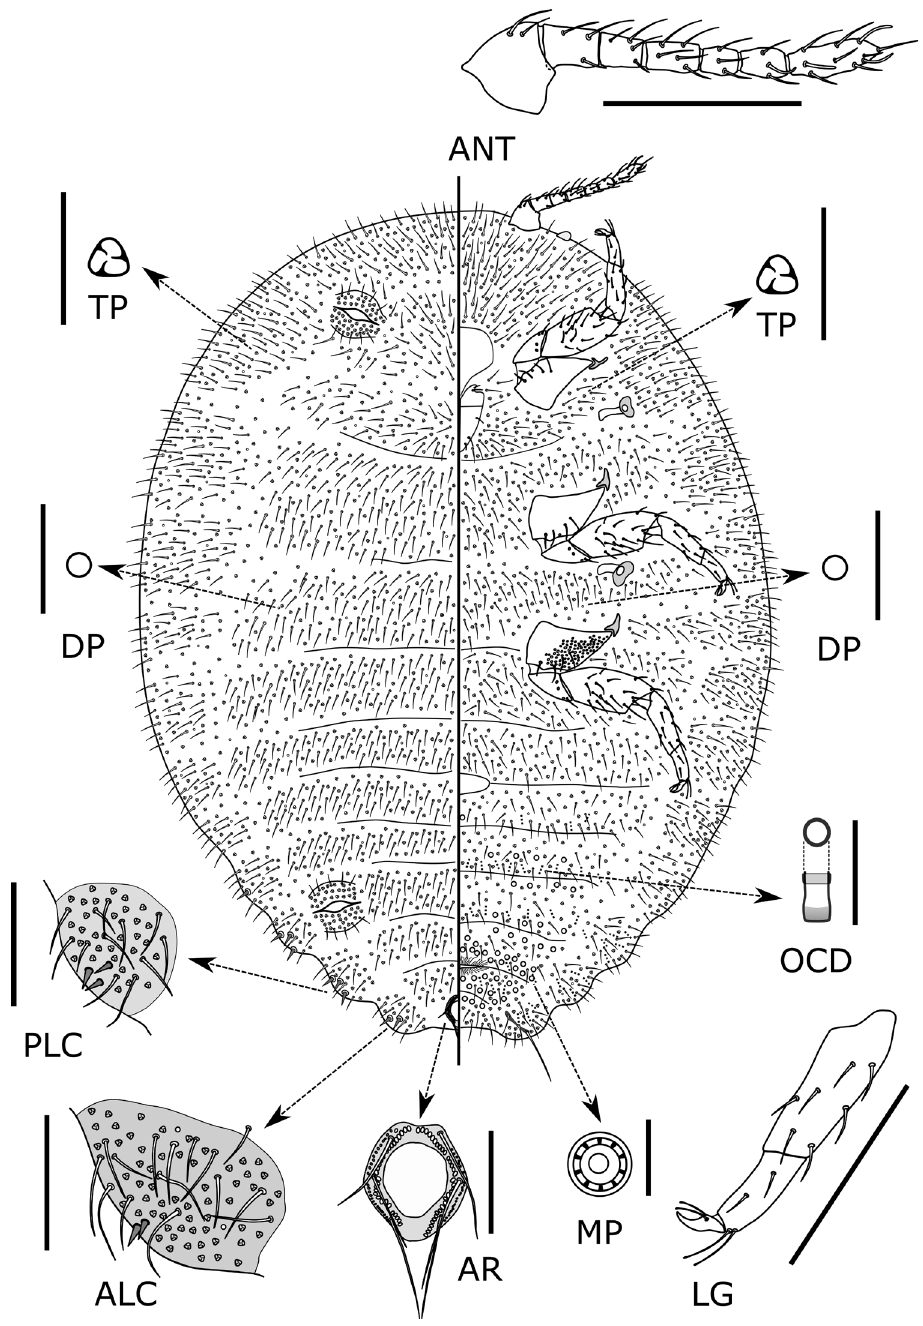
Figure 3. Formicoccus yoshinoi Tanaka , sp. nov., adult female. Abbreviations: ALC , anal lobe cerarius (C18); ANT , antenna; AR , anal ring; DP , discoidal pore; LG , hind tibia. tarsus and claw; MP , multilocu- lar pore; OCD , oral collar duct; PLC , penultimate cerarius (C17); TP , trilocular pore. Scale bars: 200 µm for ANT and LG ; 100 µm for ALC , AR , and PLC ; 10 µm for other